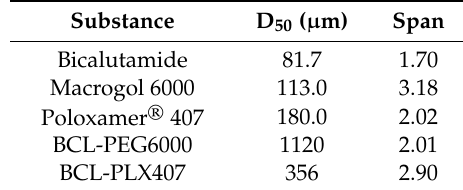
Table 1. Particles size distribution of raw bicalutamide and carriers, results obtained by the laser di ff raction method.